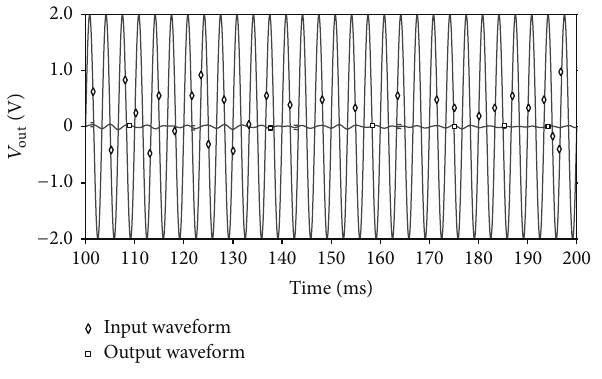
Figure 13: Input and output response at 300 Hz.